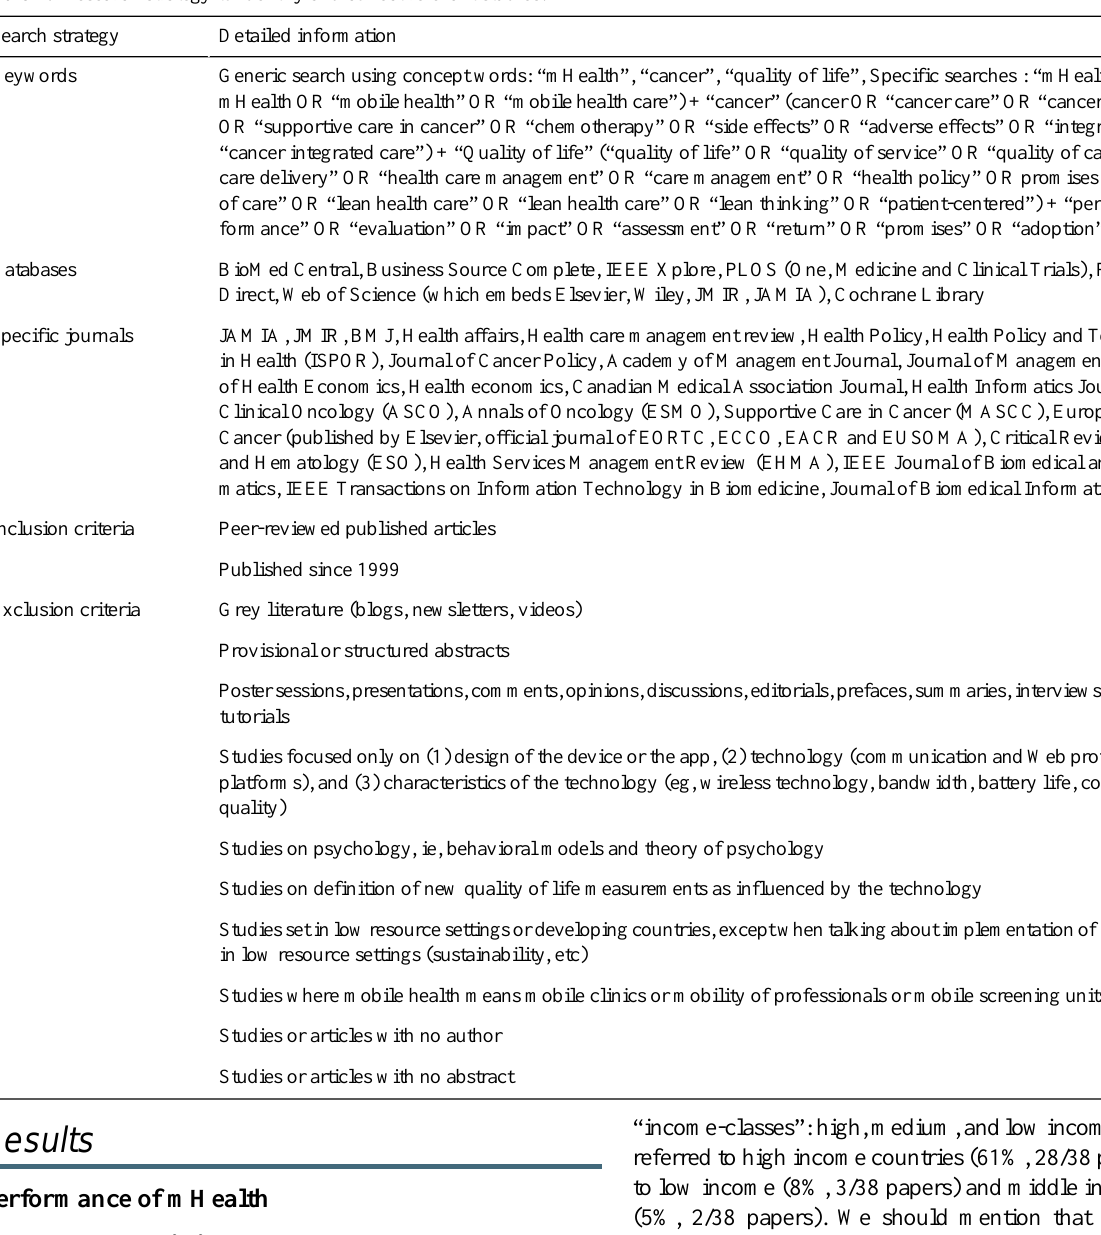
Table 1. Research strategy to identify and collect relevant studies.